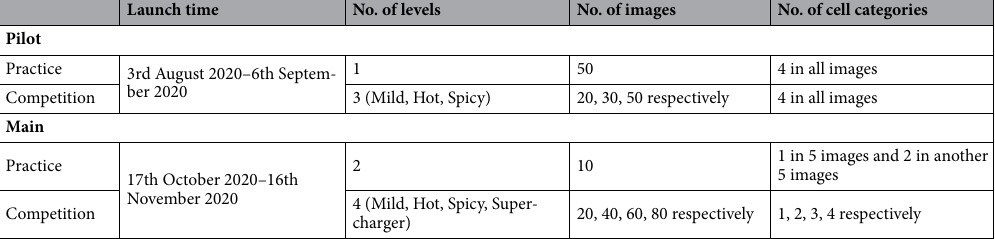
Table 1. Setup of the pilot and main competition.